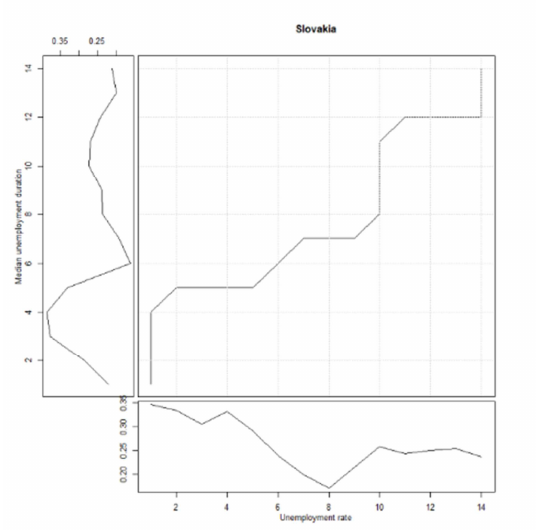
Figure 10. Alignment plots for the unemployment rate and lagged median unemployment duration for Slovakia